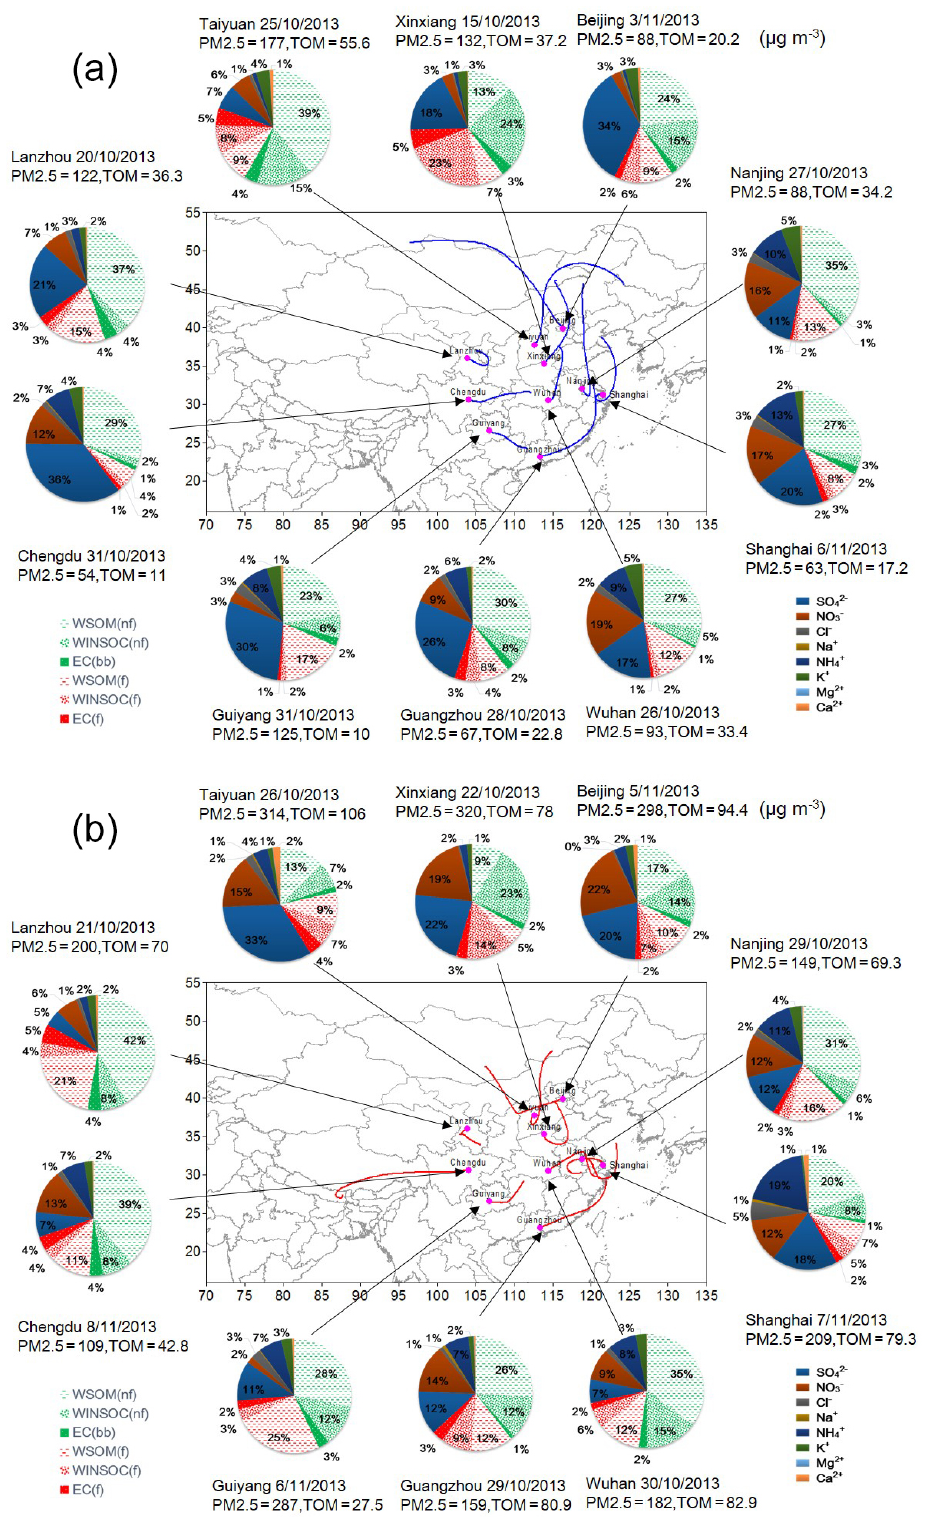
Figure 3. The chemical compositions of fine particles (PM 2 . 5 ) under non-haze (a) and haze (b) conditions during the sampling period. Air mass 5-day back trajectories (blue and red lines) for the selected samples are modeled at 500m above ground level by the Air Resources Laboratory, National Oceanic and Atmospheric Administration (Hybrid Single Particle Lagrangian Integrated Trajectory